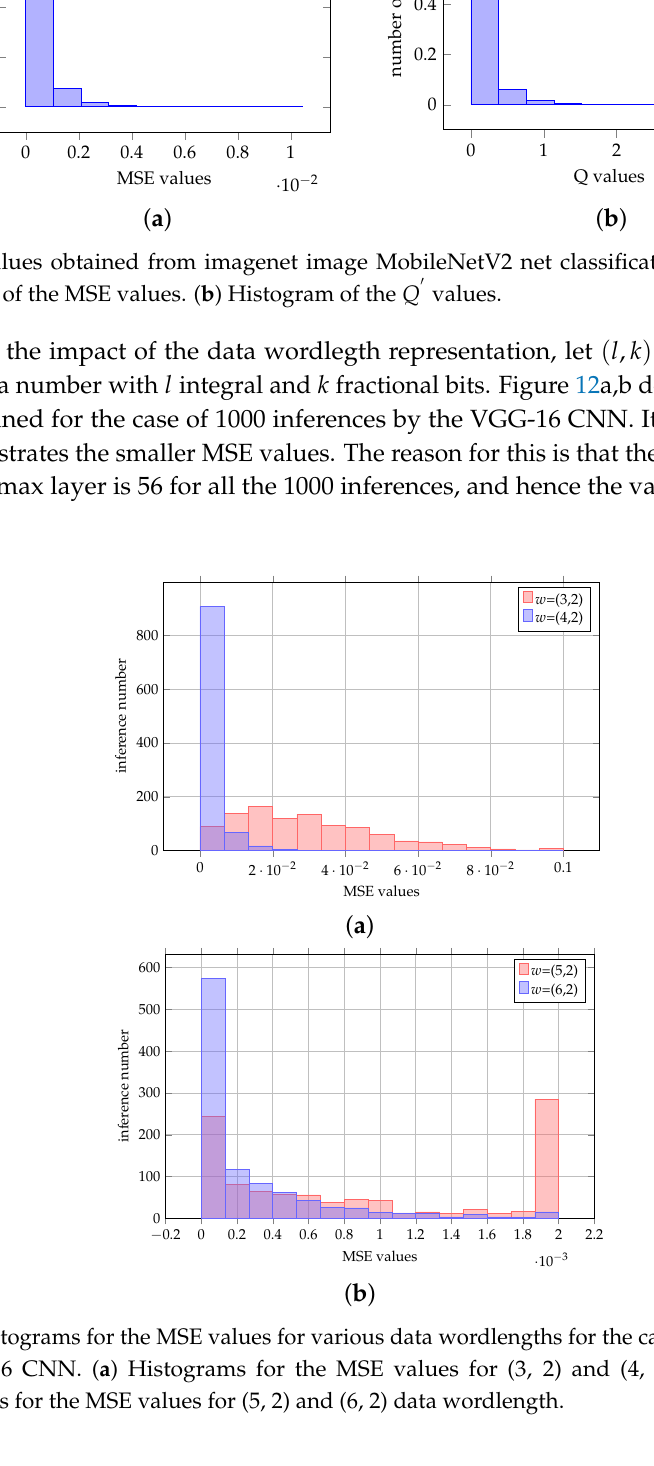
Figure 9. Values obtained from imagenet image inceptionV3 net classification for 1000 classes.